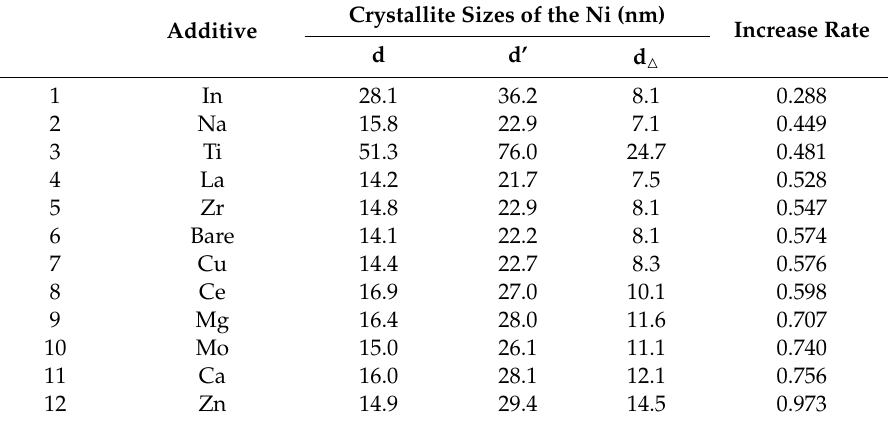
Table 3. Experimental result of anti-sintering for data mining.